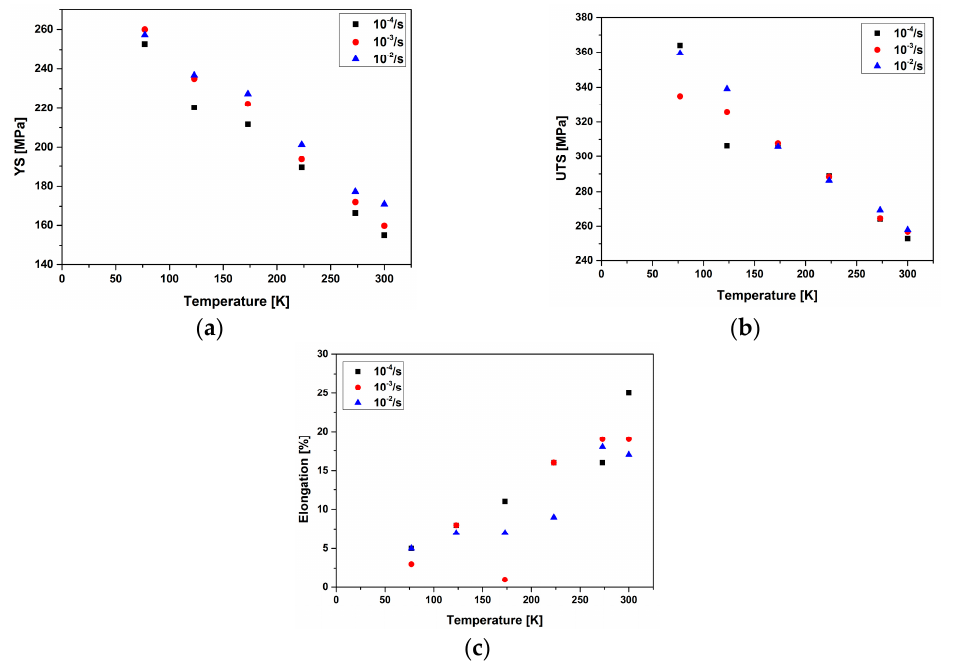
Figure 11. Temperature-dependent ( a ) yield strength, ( b ) ultimate tensile strength, and ( c ) elongation to fracture of AZ31 sheets (plotted after [25]). Table 8. Composition of magnesium alloys tested in [26–30].